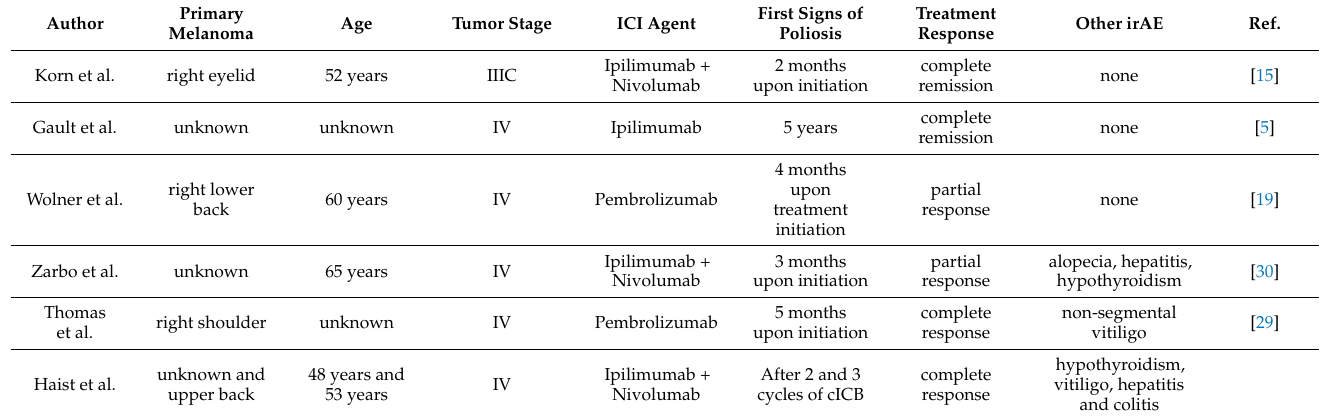
Table 1. Summary of all reports describing the event of poliosis during checkpoint-inhibitor therapy for patients with advanced melanoma and response to